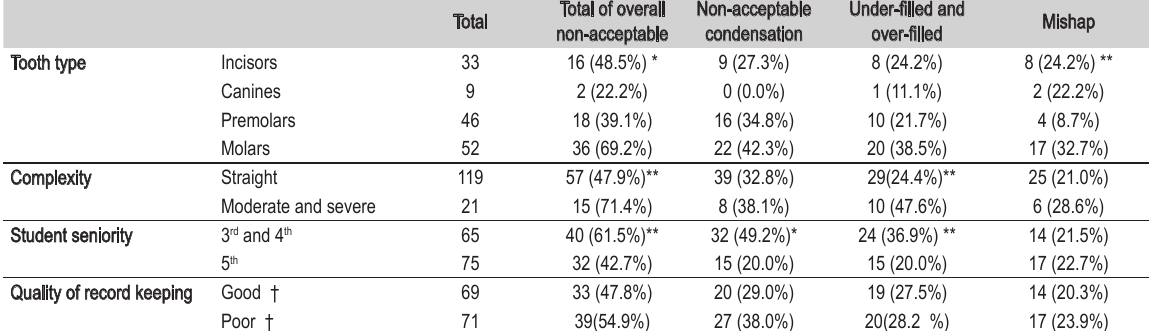
Table 4 - Non-acceptable root canal fillings according to tooth type, complexity, student seniority, and quality of record